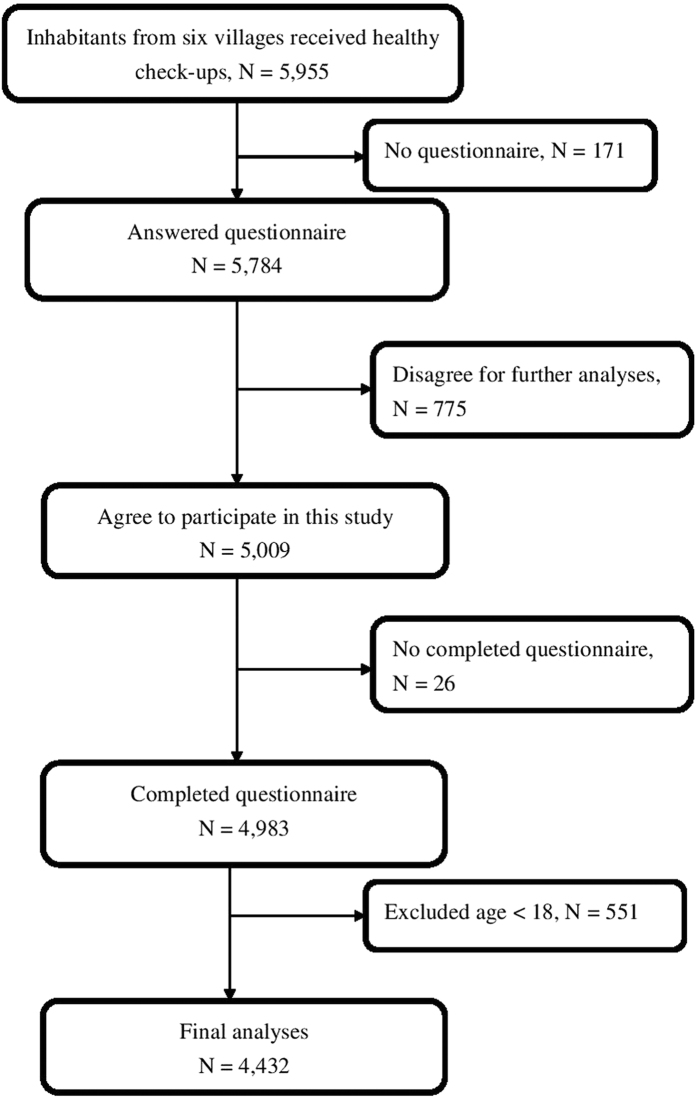
Study flowchart.